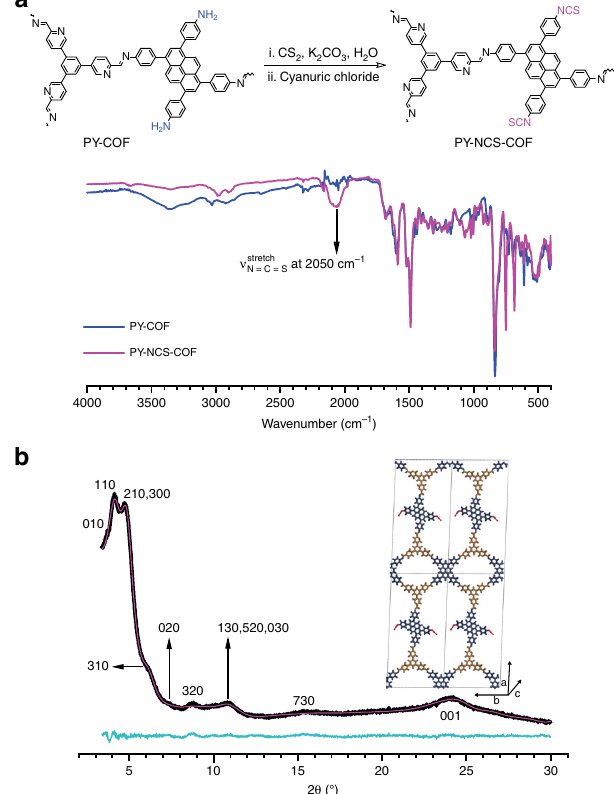
Fig. 7 Post-crystallization amine to isothiocyanate group interconversion reaction with PY-COF. a FT-IR spectrum of PY-NCS- and PY-COF showing the appearance of ν N = C = S(stretch) signal post modi fi cation. b PXRD pattern of PY-NCS-COF with corresponding Rietveld re fi nement (magenta) showing good fi ts to the experimental data (black) with minimal differences. The turquoise trace shows the difference between the experimental data and the re fi nement. The corresponding Miller indices of the identi fi able re fl ections are shown as well. The inset shows an illustration of the COF structure model (viewed along the stacking